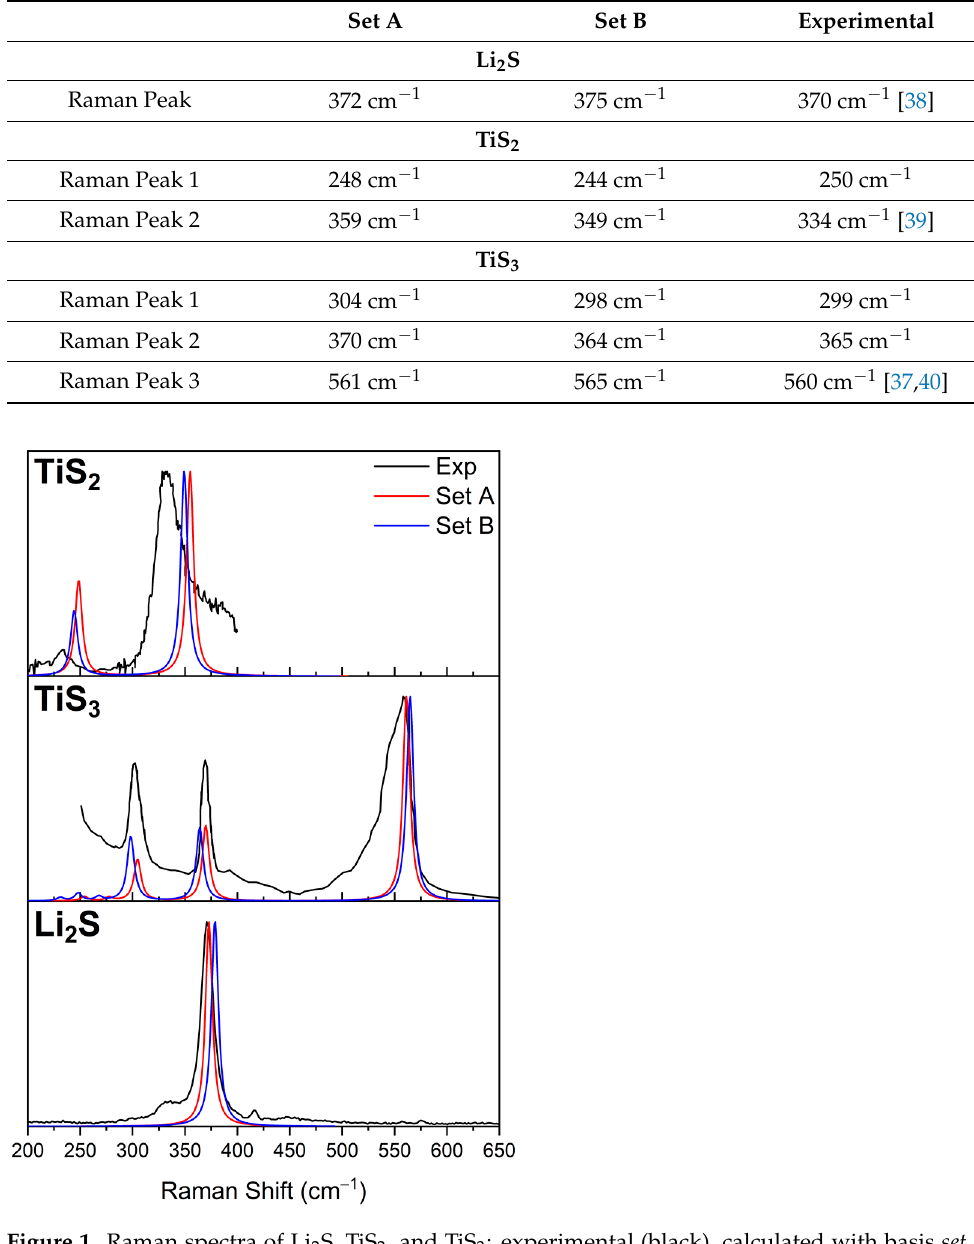
Figure 1. Raman spectra of Li 2 S, TiS 2 , and TiS 3 : experimental (black), calculated with basis set A (red), and calculated with basis set B (blue). Li 2 S has been simulated at B3LYP, whereas B3LYP-D2 * level of computation has been adopted for TiS 2 and TiS 3 .